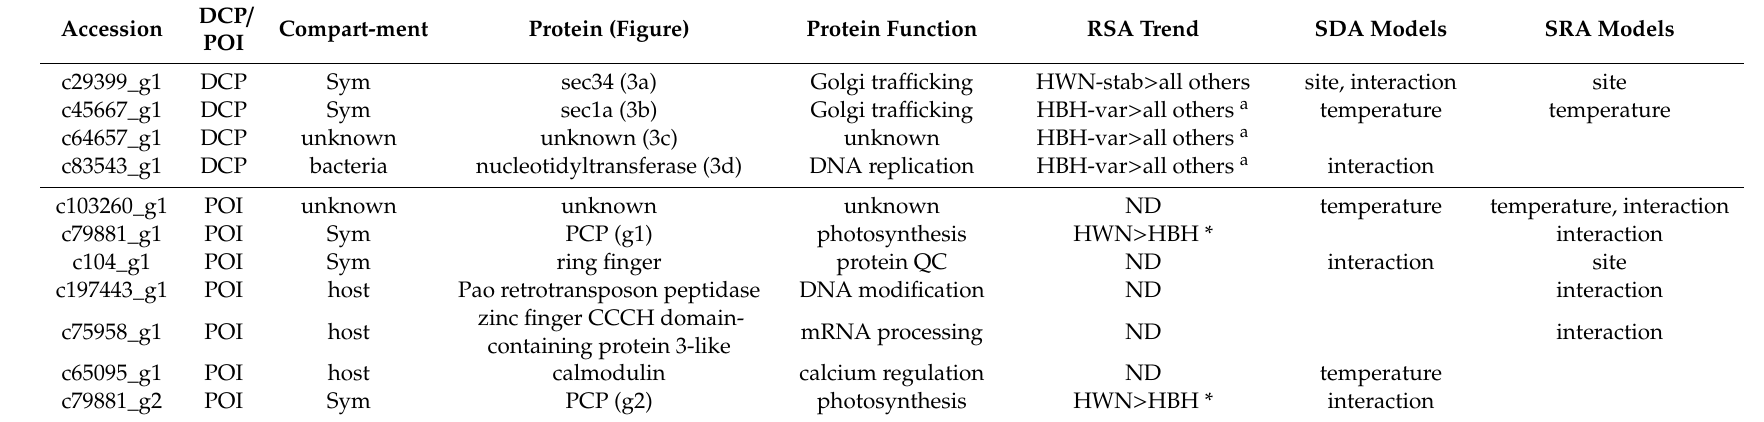
Table 4. Summary of most di ff erentially concentrated proteins (DCPs) and “proteins of interest” (POIs). None of these proteins were identified in prior 2-dimensional gel electrophoresis-based analyses. Please note that the two peridinin-chlorophyll A-binding protein (PCP) isoforms di ff er slightly in sequence (see online supplemental data file for exact peptide sequences.). For a graphical depiction of the compartmental and functional breakdown, please see Figure 1. HBH = Houbihu (upwelling site). HWN = Houwan (non-upwelling site). ND = no di ff erence. QC = quality control (processing, modification, and nascent folding). RSA = response screening